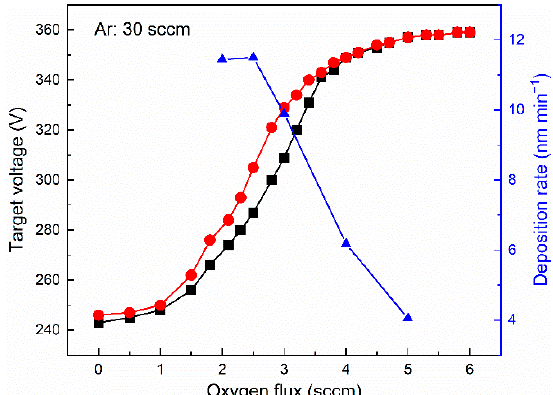
Figure 1. The relationship curves of target voltage and deposition rate vs. O 2 flux during reactive magnetron sputtering for preparation of TaO x thin films. (Black line is the target voltage change when oxygen flux rate increases, red line is the target voltage change when oxygen flux decreases, and blue line is deposition rate).